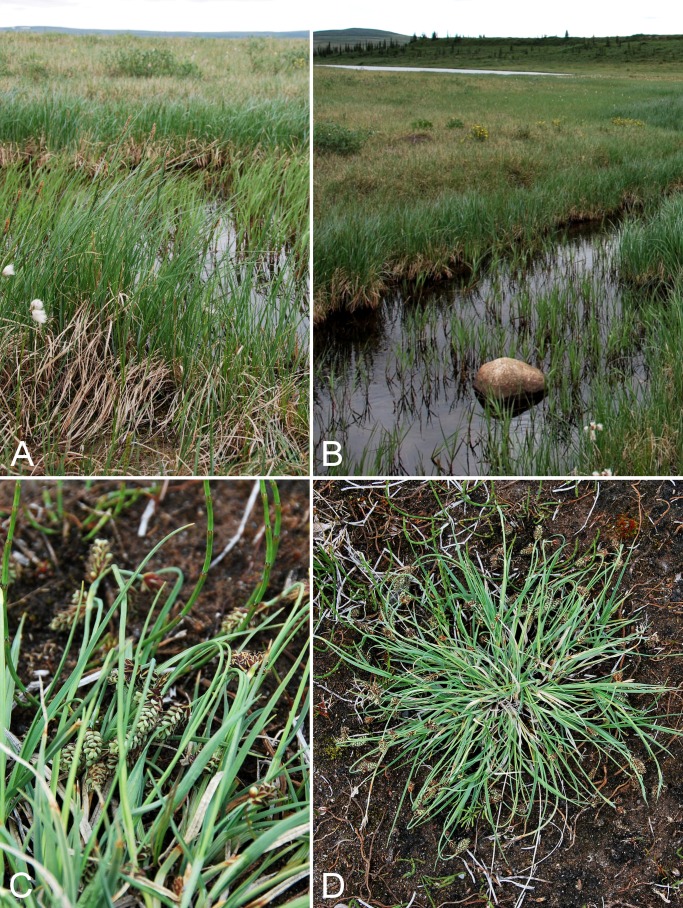
Carex aquatilis subsp. stans and C. bicolor.Carex aquatilis subsp. stans: (A) habit, Saarela et al. 3585. (B) Habitat, Saarela et al. 3585. Carex bicolor: (C) inflorescences, Saarela et al. 3857. (D) Habit, Saarela et al. 3857. Photographs by J. M. Saarela.